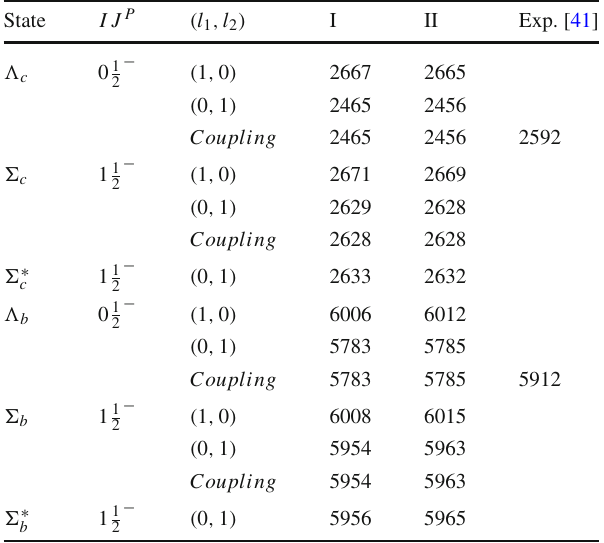
Table 4 The low-lying orbital excited energies of qqQ baryons (unit: MeV)